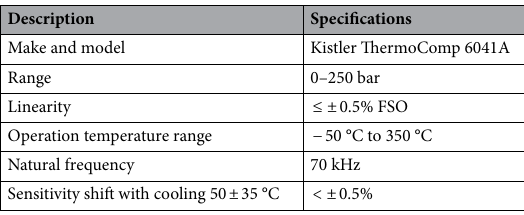
Table 3. Specifications of Kistler piezoelectric transducer 6125B.